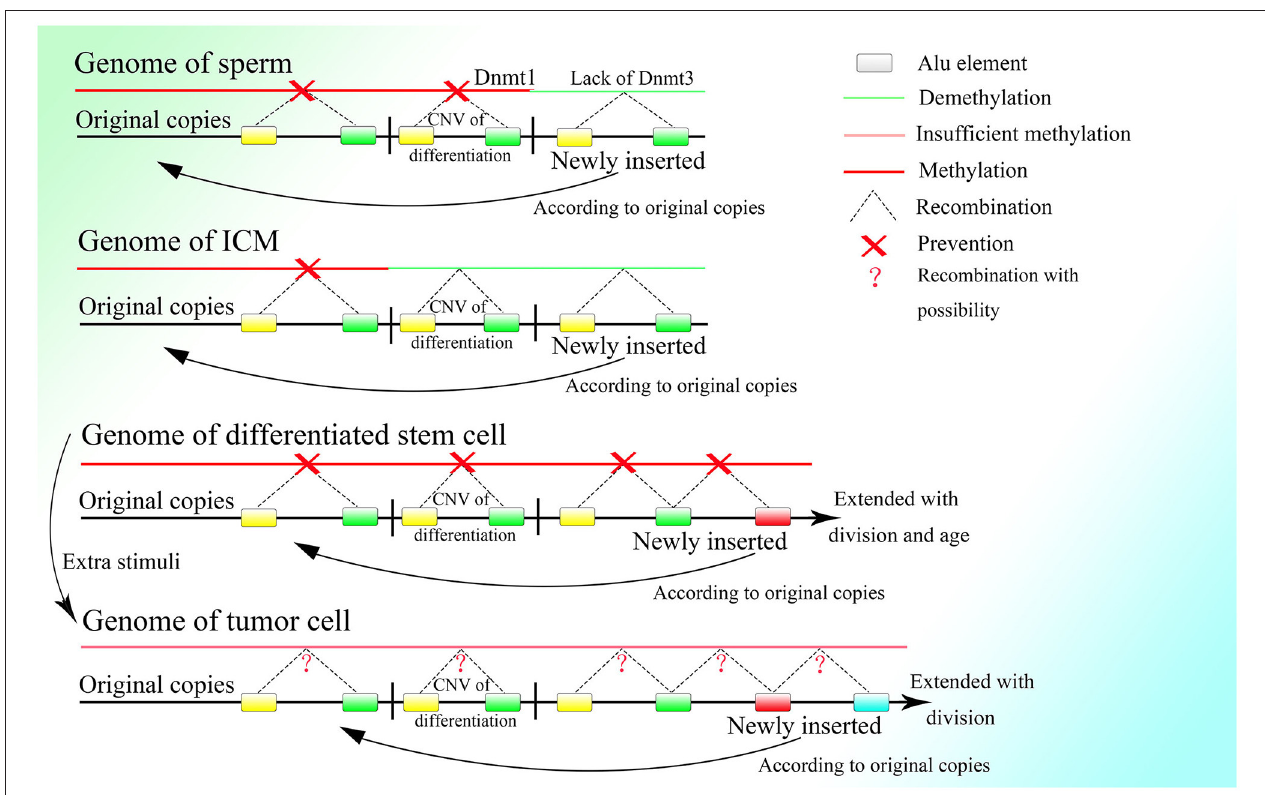
FIGURE 6 | The methylation status of different kinds of cells. Demethylation under regulation can be seen in the germ line cell and embryonic cell leading to the deletion of specific regions on the genome, whereas in the somatic cell after birth, methylation is sustained at a high level and is strictly irreversible. Methylation is decreased in the tumor cell, which might bring about unpredictable HR among Alu elements and at the same time, the insertion would also occur more frequently with increased expression of corresponding